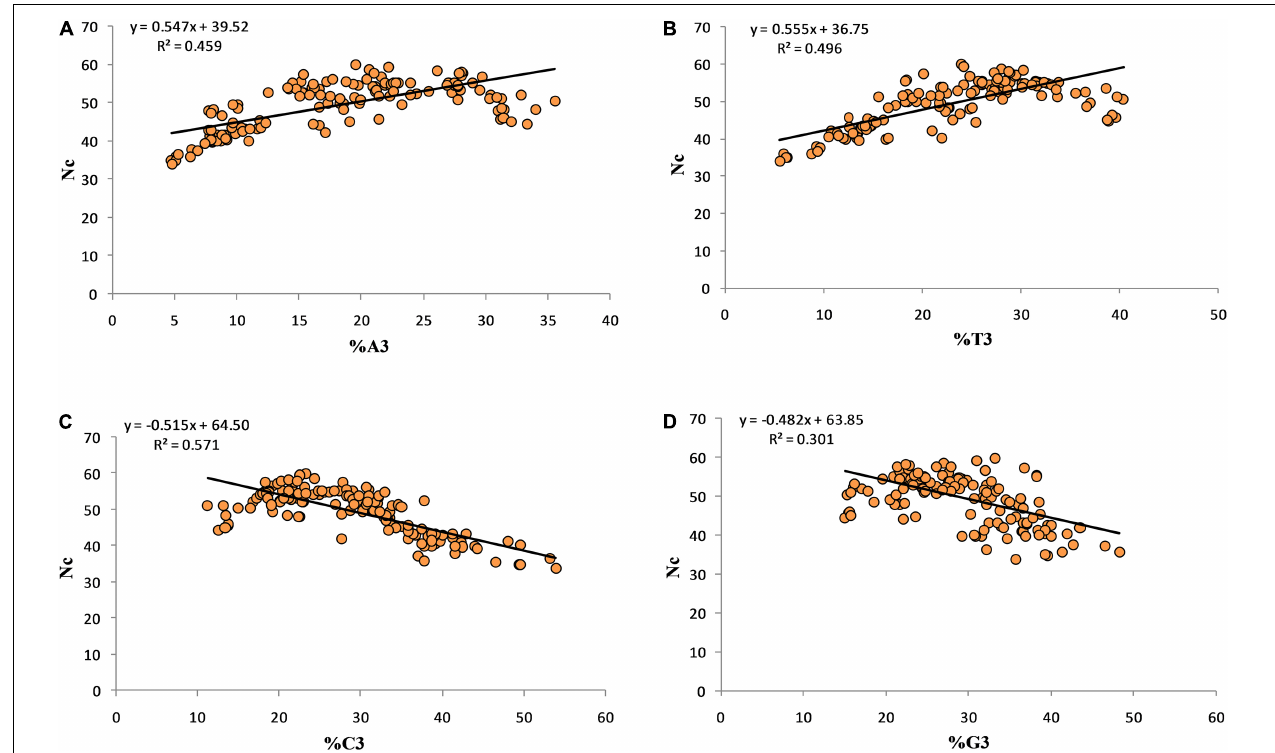
FIGURE 3 | Regression analysis between the Nc and third position of codon.